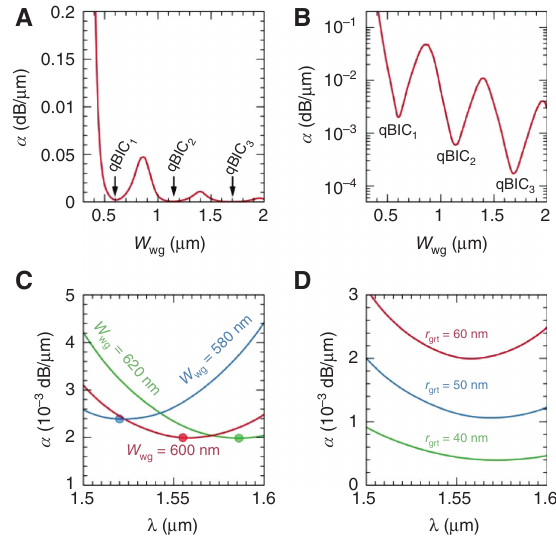
Figure 2: Diffraction properties for BIC-based SWGA. Calculated (A) linear-scale and (B) logarithmic-scale diffraction strength α with varied waveguide width w at the 1.55 μ m wg wavelength. The diffraction strength periodically reaches a minimum value at some critical waveguide widths w , which is mainly due c to the BIC effect. The first critical waveguide width is calculated to = 600 nm. (C) Calculated α spectra with varied w be w . The dot c,1 wg markers denote the zero-dispersion wavelengths. For the BIC-based = w SWGA with w , the interference-induced zero dispersion can be wg c,1 obtained at the central wavelength, leading to a flattened dispersion curve. (D) Calculated α spectra with varied nanogroove radius r grt